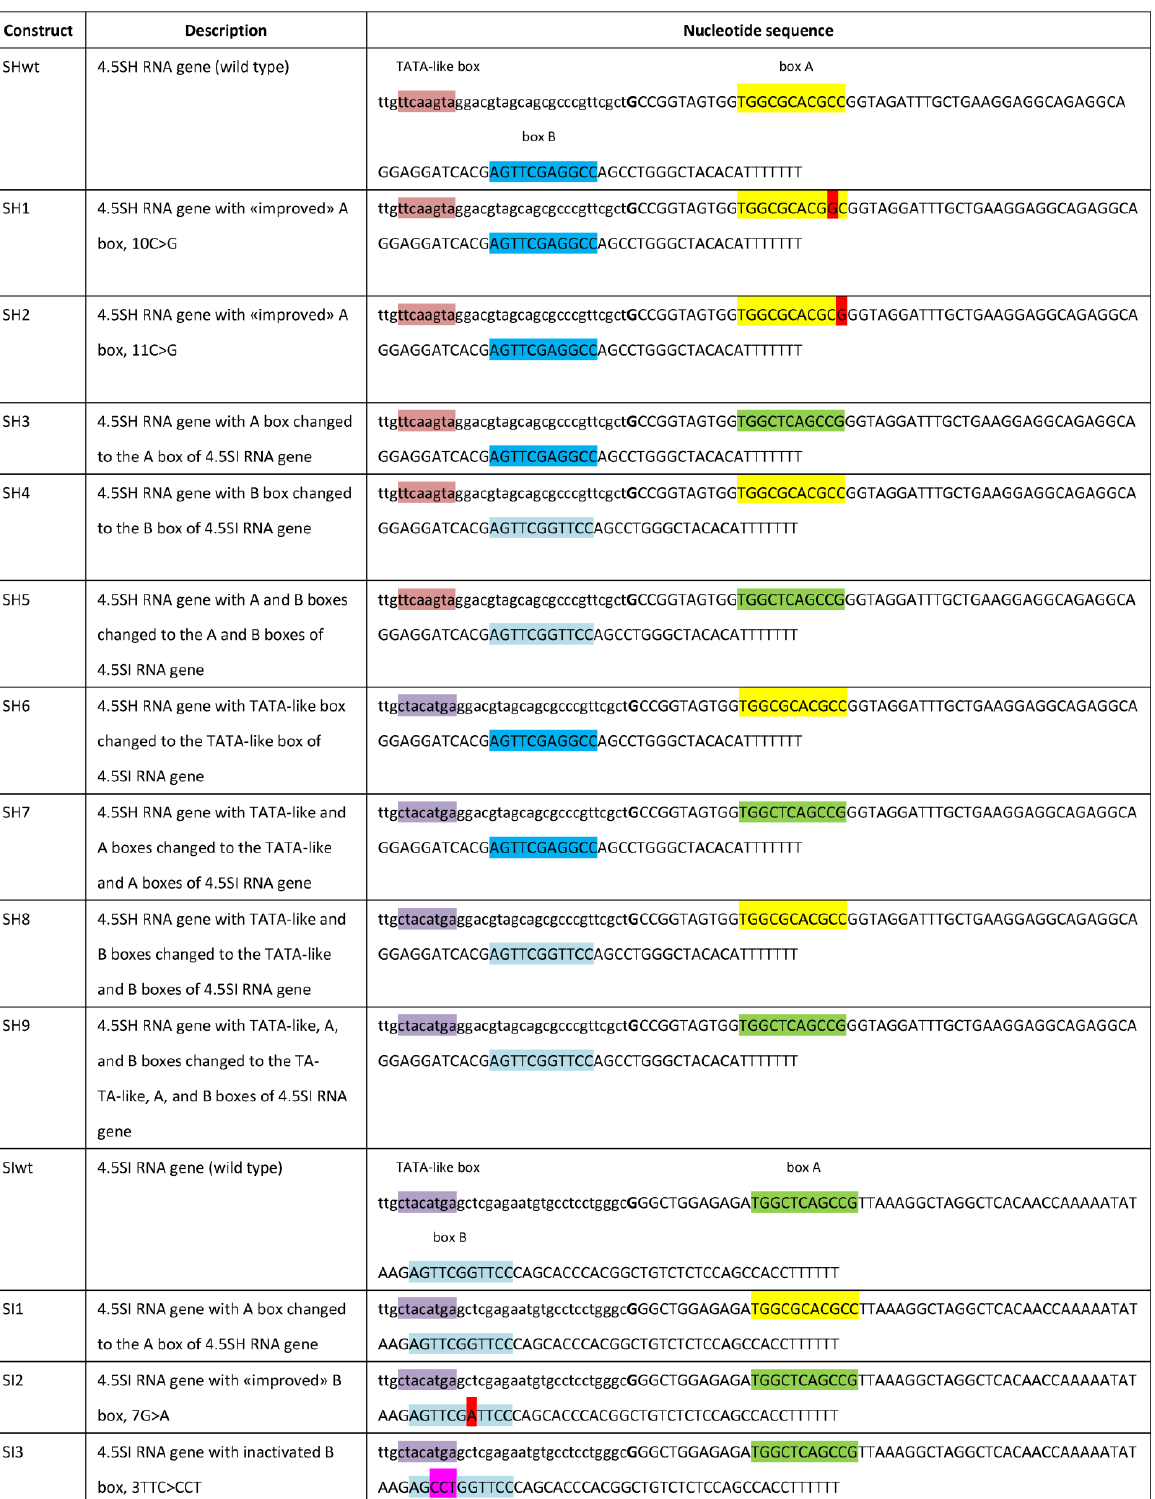
Figure 2. Constructs containing mouse 4.5SH RNA and 4.5SI RNA wild - type genes or their derivatives. Identical pol III promoter boxes A and B, as well as TATA - like boxes, are highlighted in different colors. The 5′ - flanking sequences are given in lowercase. The transcribed sequences are given in uppercase. The T 6–7 block at the end of the genes serves as a pol III transcription terminator. The nucleotides replaced to match the box A or box B consensus sequences are highlighted in red. The trinucleotide in box B marked in magenta was replaced to reduce promoter